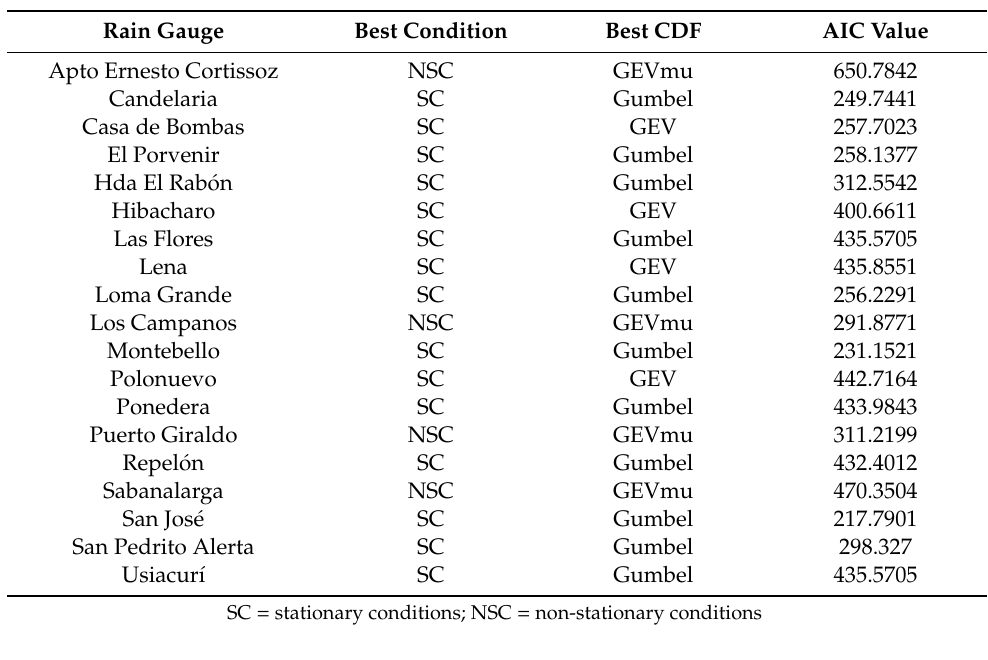
Table 8. Best scenario for each rain gauge.